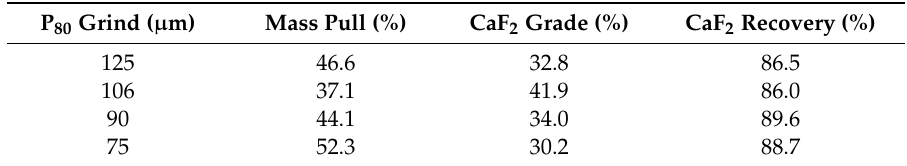
Table 3. E ff ect of grind on CaF 2 grade–recovery relationship for ore B using Arizona Sylfat FA2 collector in rougher cells.